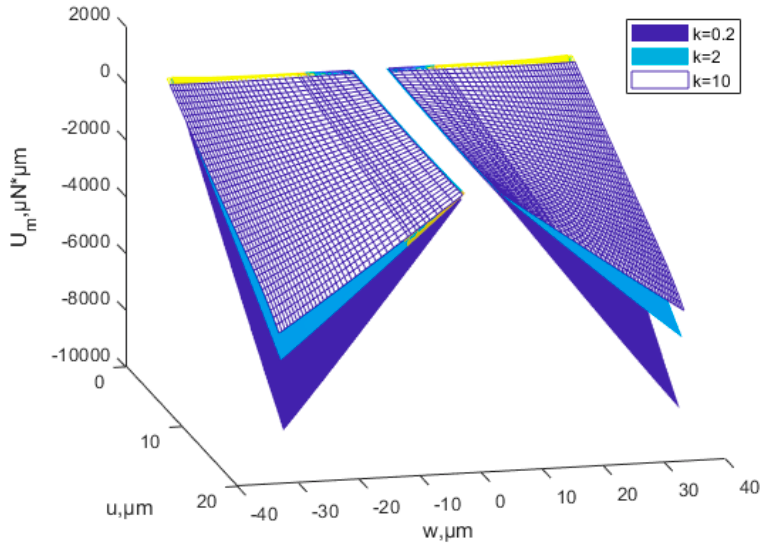
Figure 15. Influence of the power-law distribution of the scale effect on membrane energy of the FGM plate.